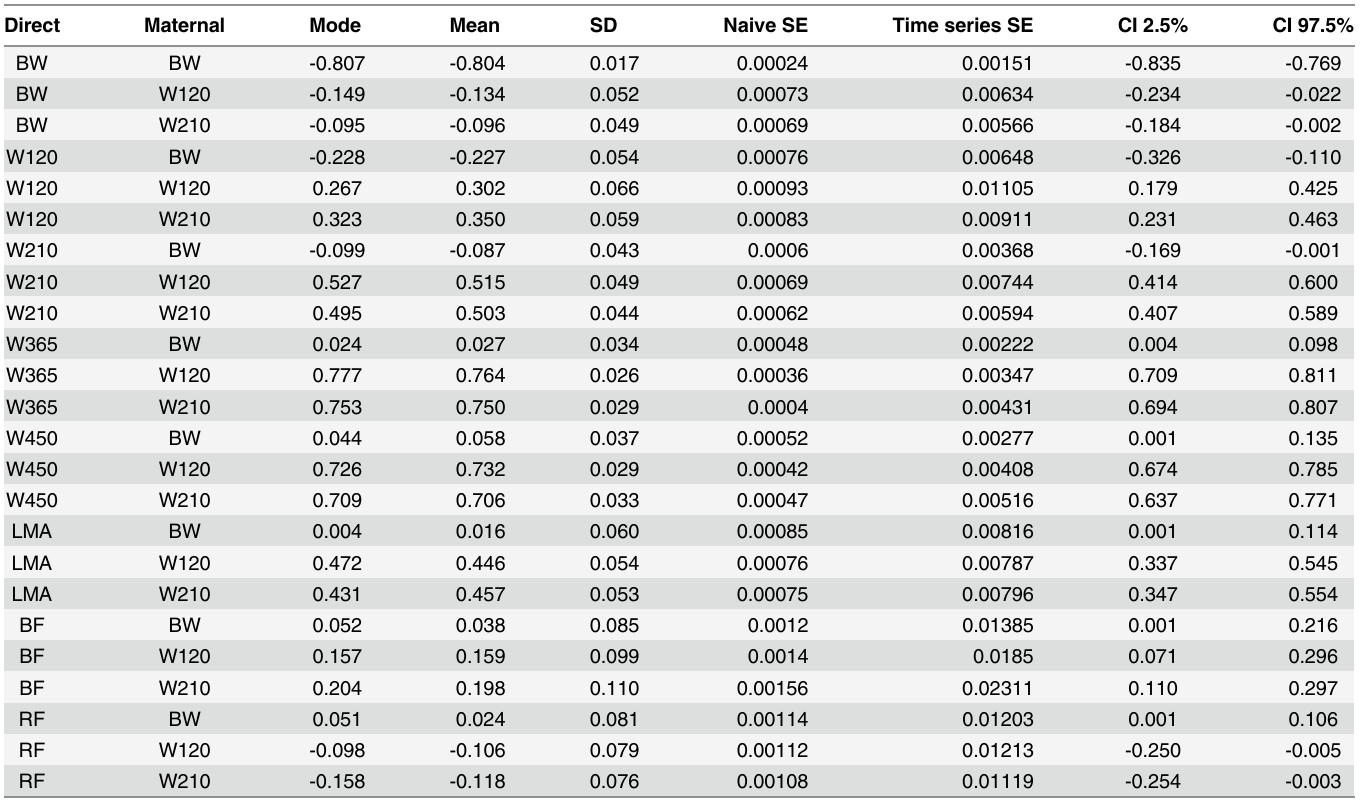
Table 7. Marginal posterior distributions of the correlation between genetic additive direct and maternal correlation among the growth and car- cass traits in Polled Nellore cattle.